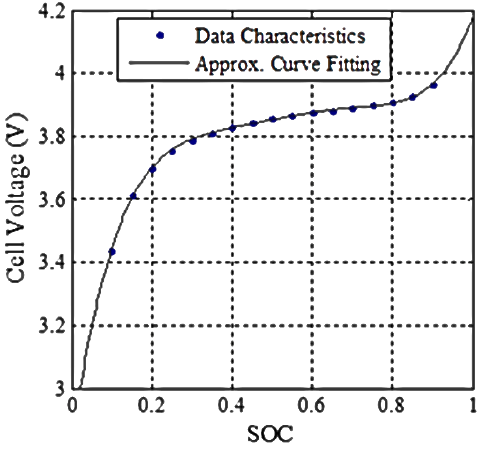
Figure 3. OCV and SOC relationship model of the Li-ion battery.